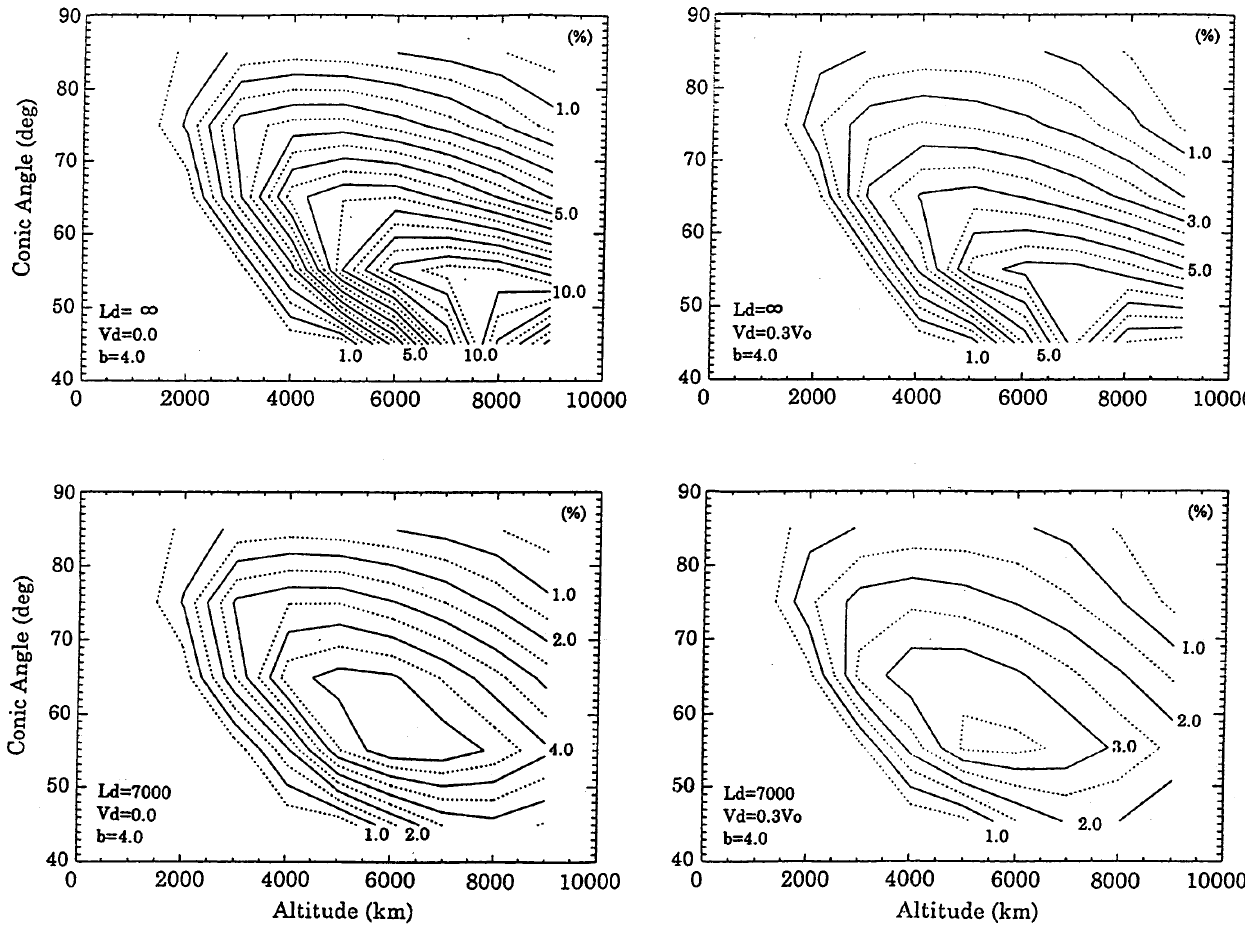
Fig. 5. Four examples of calculated occurrence frequencies as a function of altitude and conic angle under non-adiabatic motion (cid:133) b (cid:136) 4 : 0 (cid:134) . The occurrence frequencies of conics with a conic angle of 85 (cid:14) are adjusted to match the